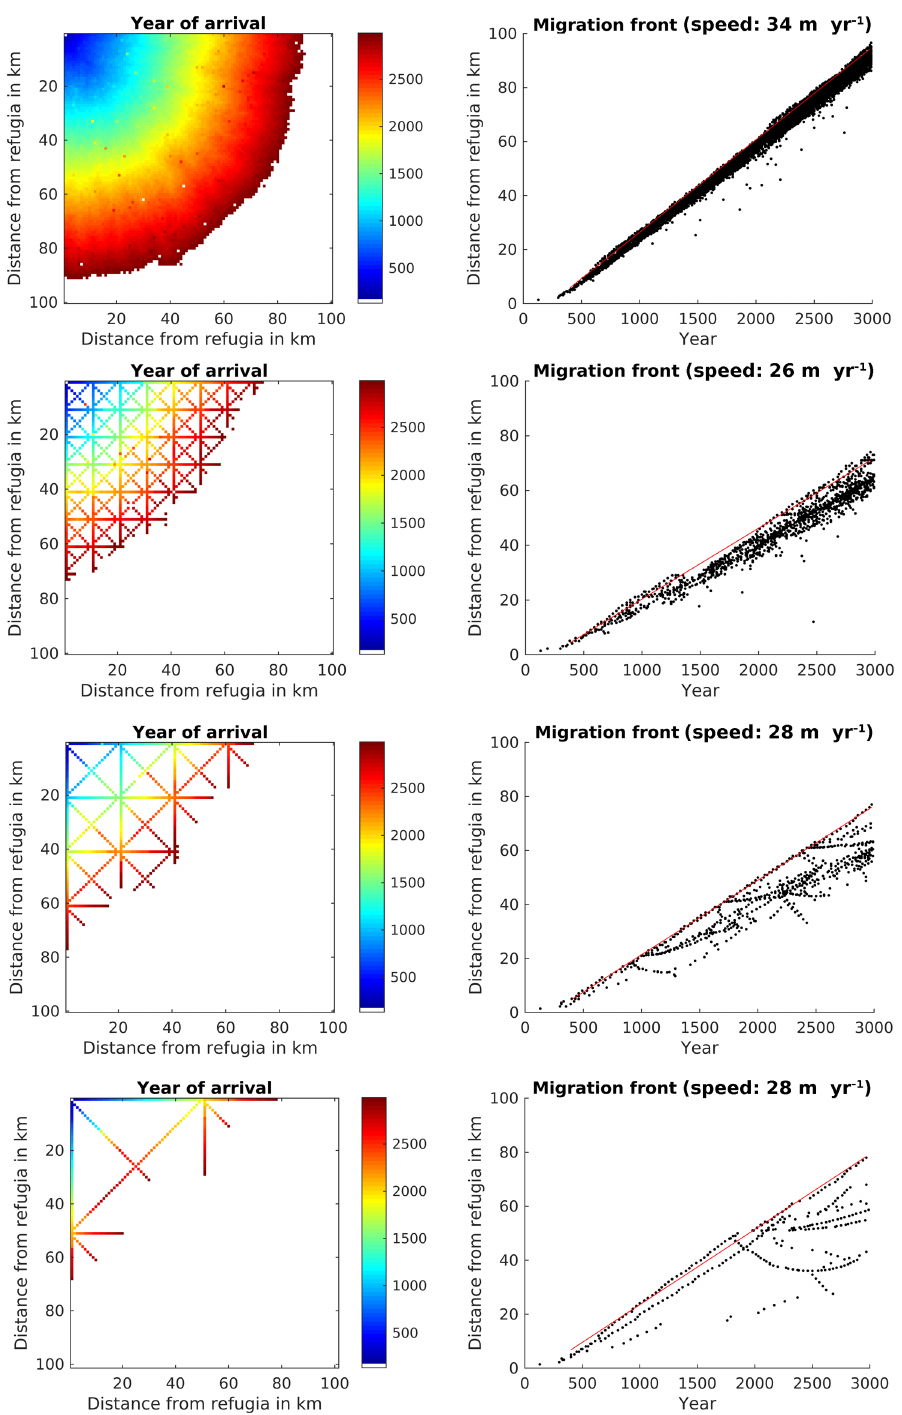
Figure 4. Spread of Fagus sylvatica through an area of 100 × 100 grid cells with static climate using the FFTM algorithm with no corridors or corridors every 10km, 20km, or 50km. The left panels display the time when F. sylvatica first reached an LAI of 0.5. F. sylvatica is allowed to establish freely only in the upper left corner. The right panels show the distance of the grid cells with LAI 0.5 for F. sylvatica from the starting point. The red line indicates the 95th percentile of the grid cells farthest away from the starting point. The migration speed is calculated as slope of this line, taking only grid cells at least 5km away from the starting point into account to avoid some initial establishing